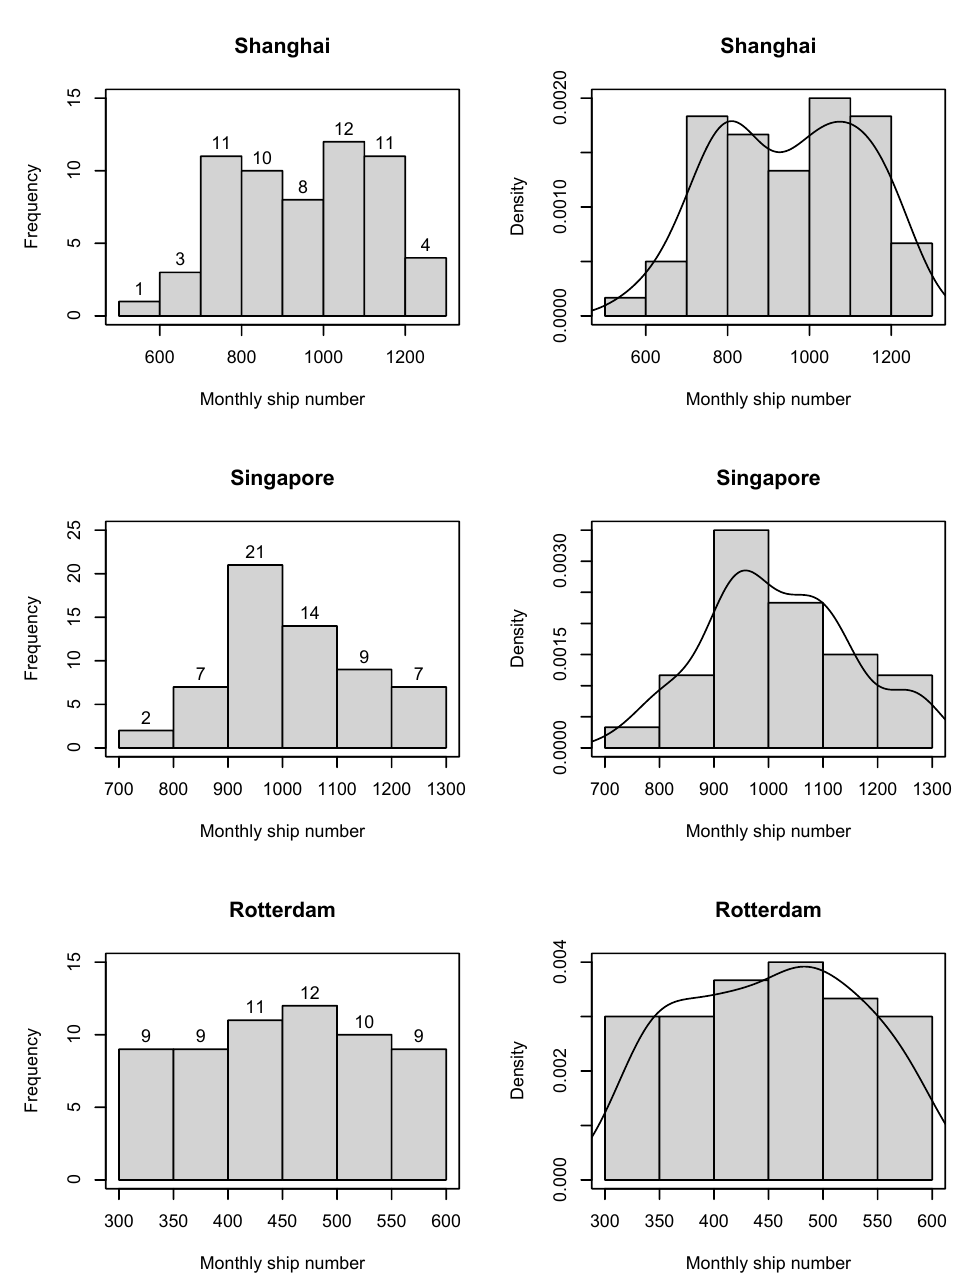
Figure 4. Frequency and probability density distribution of monthly ship flow